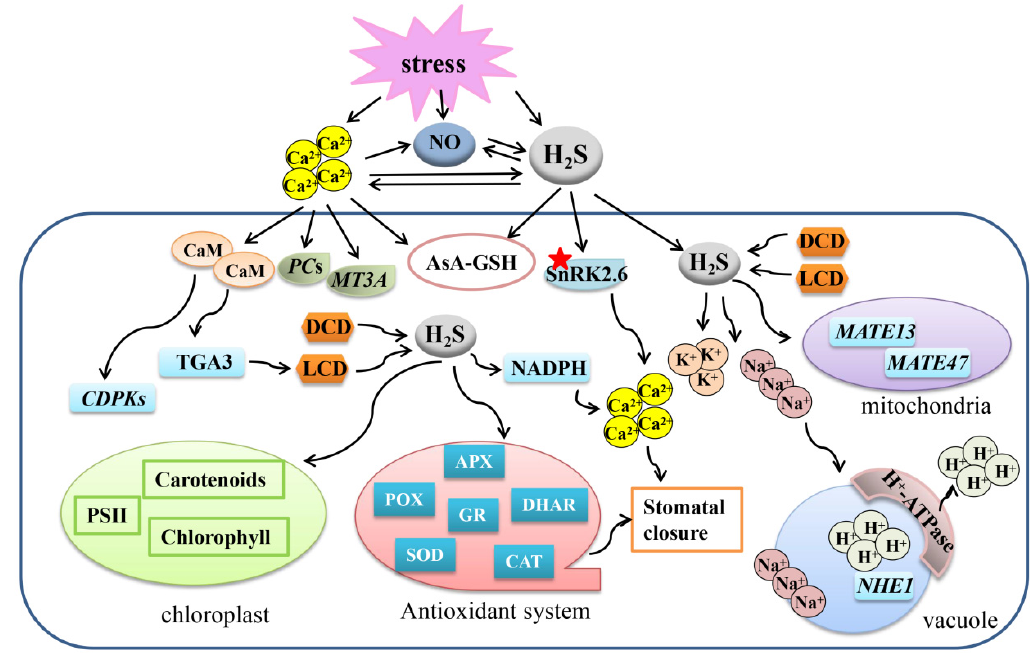
Figure 2. Overview for the mechanisms of the crosstalk between Ca 2+ , NO, and H 2 S to regulate plant response to abiotic stresses. A protein marked with a red asterisk means that the protein can be persulfided. Ca 2+ , calcium ion; NO, nitric oxide; H 2 S, hydrogen sulfide; LCD, L-cysteine desulfhydrase; DCD, D-cysteine desulfhydrase; APX, ascorbate peroxidase; SOD, superoxide dismutase; GR, glutathione reductase; POD, peroxidase; CAT, catalase; CaM, calmodulin; PCs, phytochelatin synthase; MT3A, metallothionein-like type 3; CDPKs, Ca 2+ -dependent protein kinases; AsA-GSH, ascorbate-glutathione cycle; DHAR, dehydroascorbate reductase; POD, peroxidase; CAT, catalase.